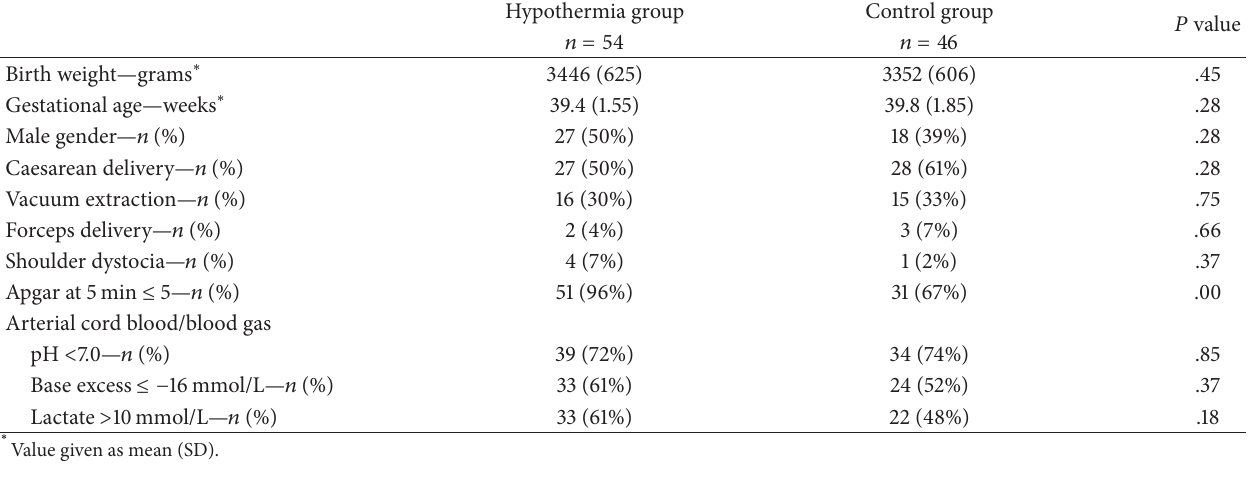
Table 1: Baseline characteristics of the study population.